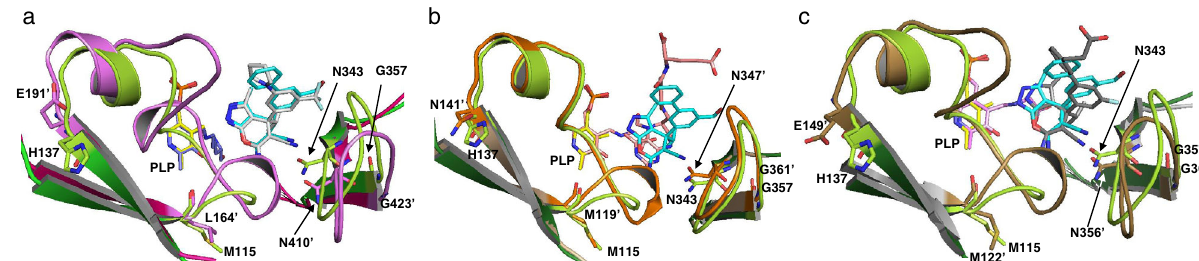
Fig. 6 Comparison of the catalytic site of efm SHMT and three other SHMTs derived from human, E. coli and P. vivax . Overlaid catalytic-site structures are shown in ( a – c ). a efm SHMT (green) and huSHMT2 (magenta), ( b ) efm SHMT (green) and ecSHMT (ivory), and ( c ) efm SHMT (green) and pv SHMT (silver) showing the divergence of the loop structures (light green, efm SHMT; pink, hu SHMT; orange, ec SHMT; gold, pv SHMT). Substrates bound to each SHMT are shown in stick representation (cyan, ( + )-SHIN-1; white, SHMT-IN-2; beige, 5-formyl-H4PetGlu; dark grey, ( + )-85). PLP binding to each SHMT is also shown in stick representation (yellow, efm SHMT; blue, hu SHMT; beige, ec SHMT; magenta, pv SHMT).